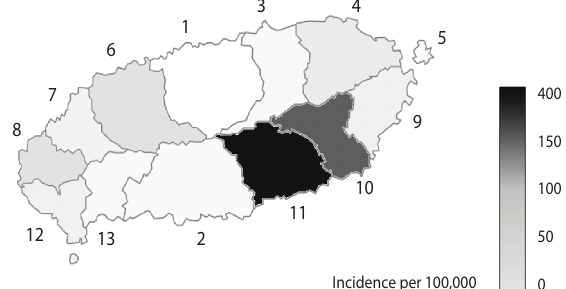
Figure 1. Average age-adjusted incidence rate per 100,000 of scrub typhus in Jeju Island, 2011-2016 (1, Jeju-si;2, Seogwipo-si; 3, Jocheon- eup; 4, Gujwa-eup; 5, Udo-myeon; 6, Aewol-eup; 7, Hallim-eup; 8, Hangyeong-myeon; 9, Seongsan-eup;10, Pyoseon-myeon; 11, Nam- won-eup; 12, Daejeong-eup; 13,